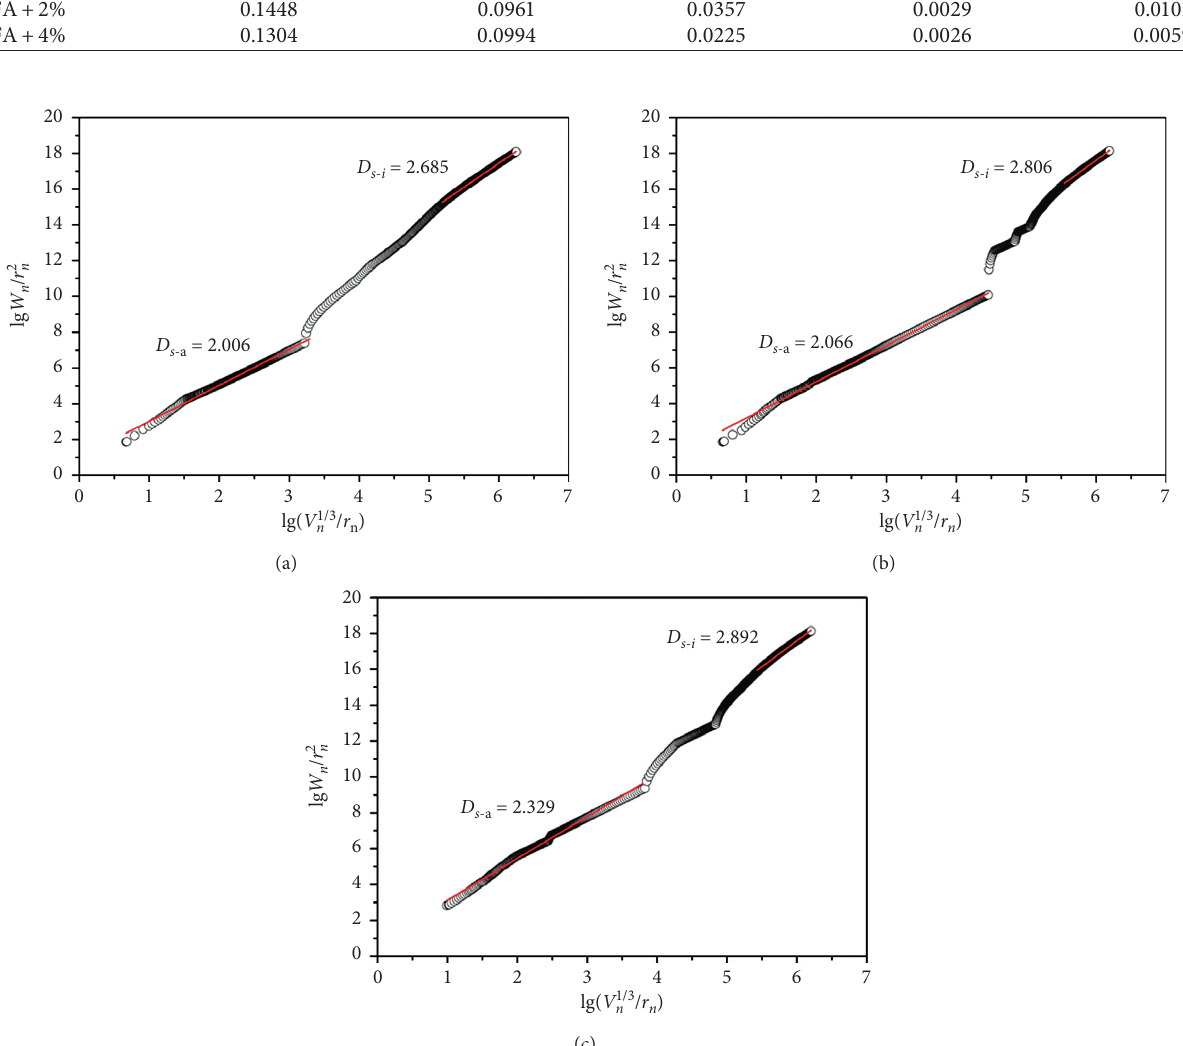
Figure 6: Logarithm plots of W